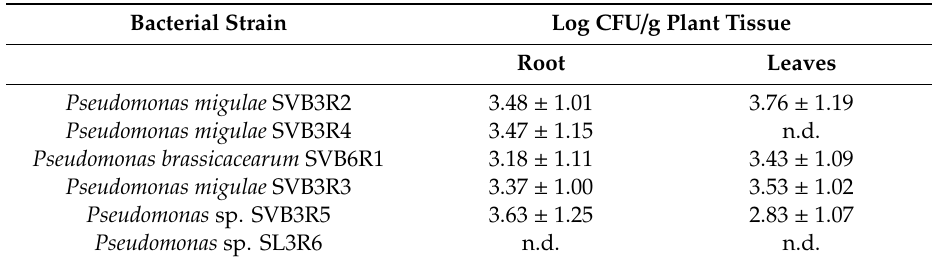
Table 3. Bacterial density inside sorghum plants following plant re-inoculation with the different strains.